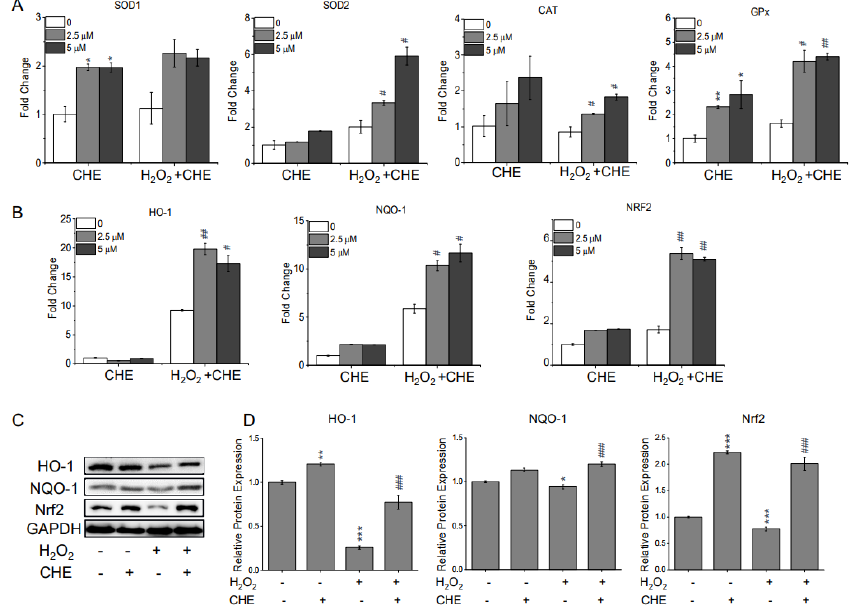
Figure 3. Involvement of the HO-1/ Nrf2 axis in the antioxidant effects of CHE. Cells were pre-treated with 2.5 or 5 μ M CHE or 0.1% DMSO (vehicle control) for 2 h and then incubated with or without 500 μ M H 2 O 2 for an additional 24 h. Afterwards, the cells were harvested to extract RNA and protein. Expression analysis of antioxidant marker genes via RT-qPCR. All the gene expression data were analyzed using Student’s t -test ( A , B ). ( C ) Cells were pre-treated with 5 μ M CHE or 0.1% DMSO for 2 h and then incubated with or without 500 μ M H 2 O 2 for an additional 24 h. HO-1, NQO-1, and Nrf2 protein levels were quantified via Western blot analysis. (D) HO-1, NQO-1, or Nrf2 expression level was plotted relative to the control level. * p < 0.05, ** p < 0.01, *** p < 0.001, versus the control group; # p < 0.05, ## p < 0.01, ### p < 0.01, versus the H 2 O 2 -treated group.